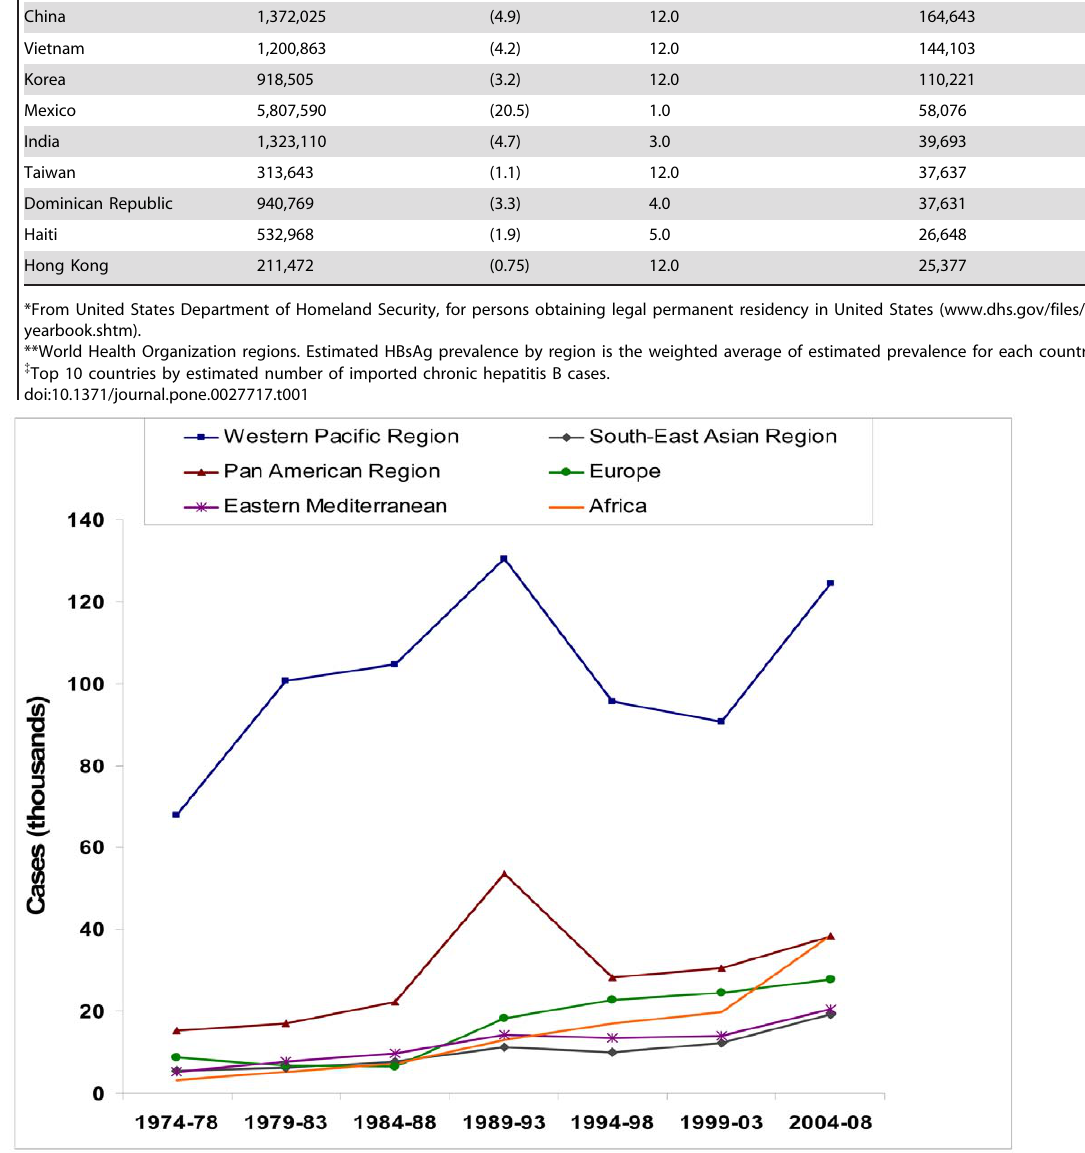
Figure 2. Estimated Cases of Imported Chronic HBV Infection by WHO Region of Origin, 1974–2008. doi:10.1371/journal.pone.0027717.g002 PLoS ONE |